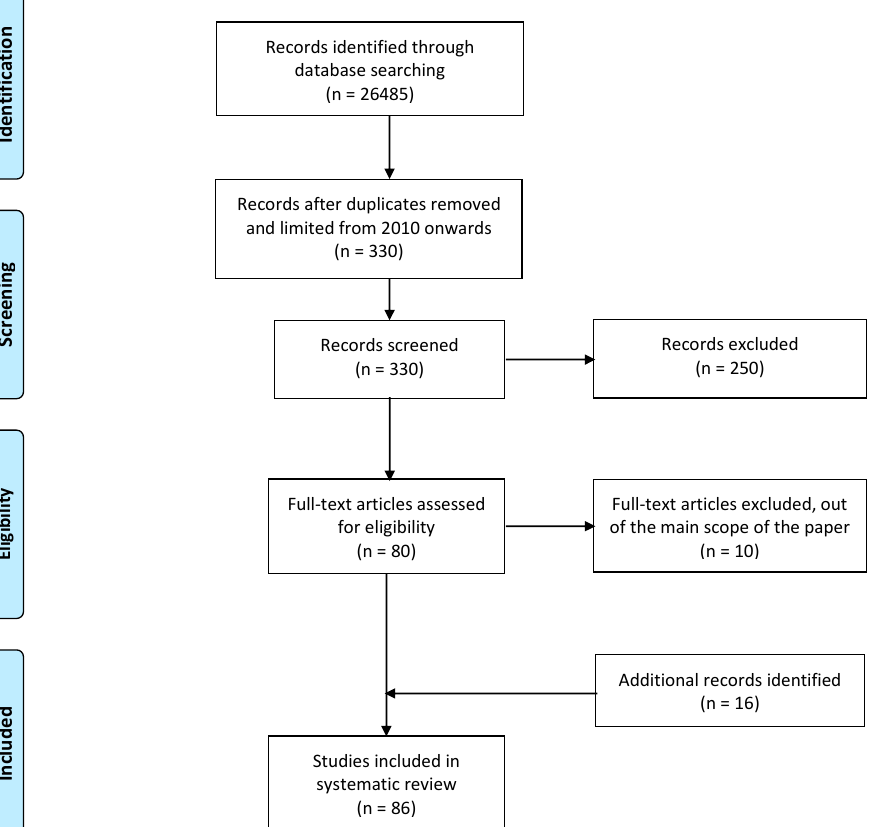
Figure 3. Schematic summary of the number of papers evaluated for this review according to the PRISMA methodology [14].